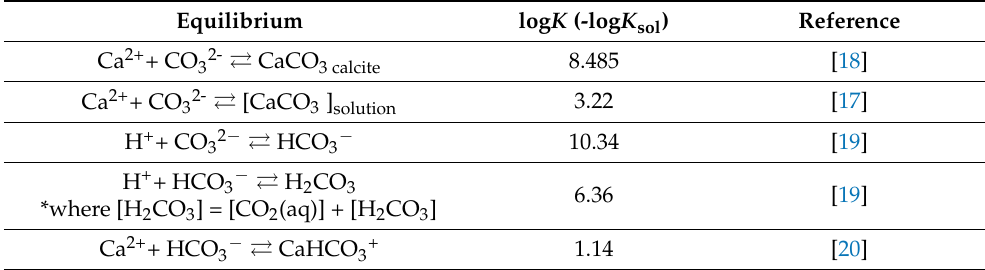
Table 2. Calcium species’ distribution as a function of pH at 25 ◦ C and I = 0 mol dm − 3 . Calcium Species, % (mol) Ca 2+ CaCO 3 solution [CaHCO 3 ] + CaCO 3 pH